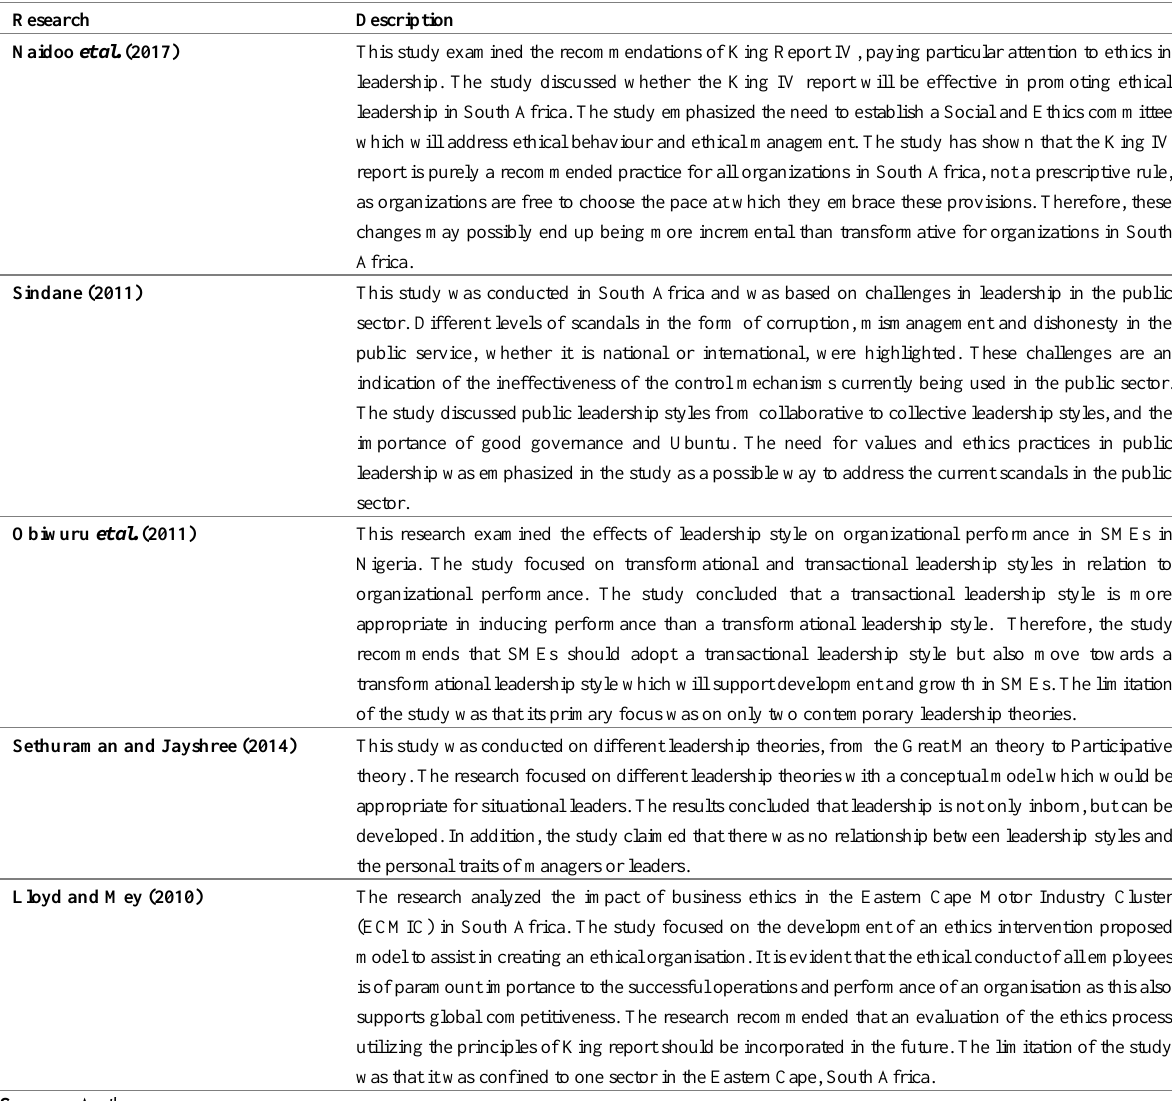
Table 2: Summary of Previous Reviewed